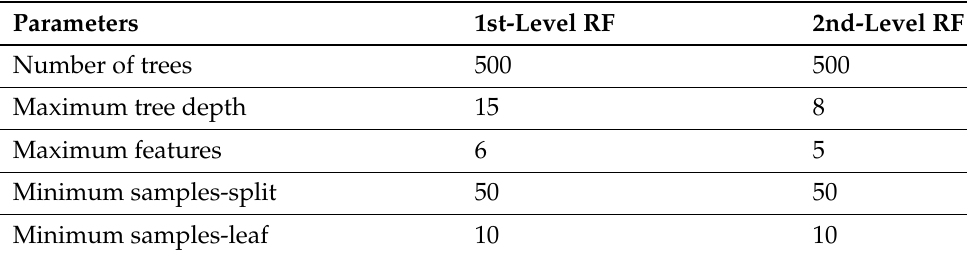
Table 4. Two-level RF classification